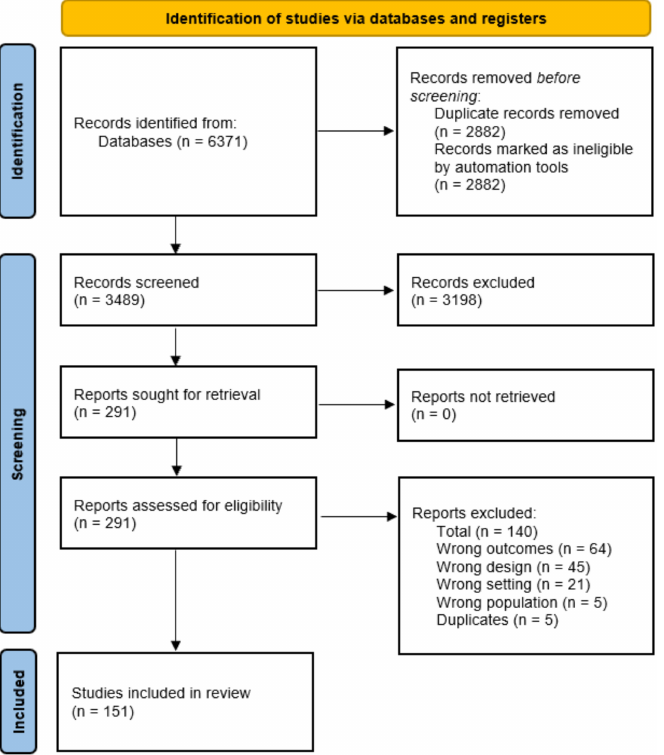
Figure 1. PRISMA Flow